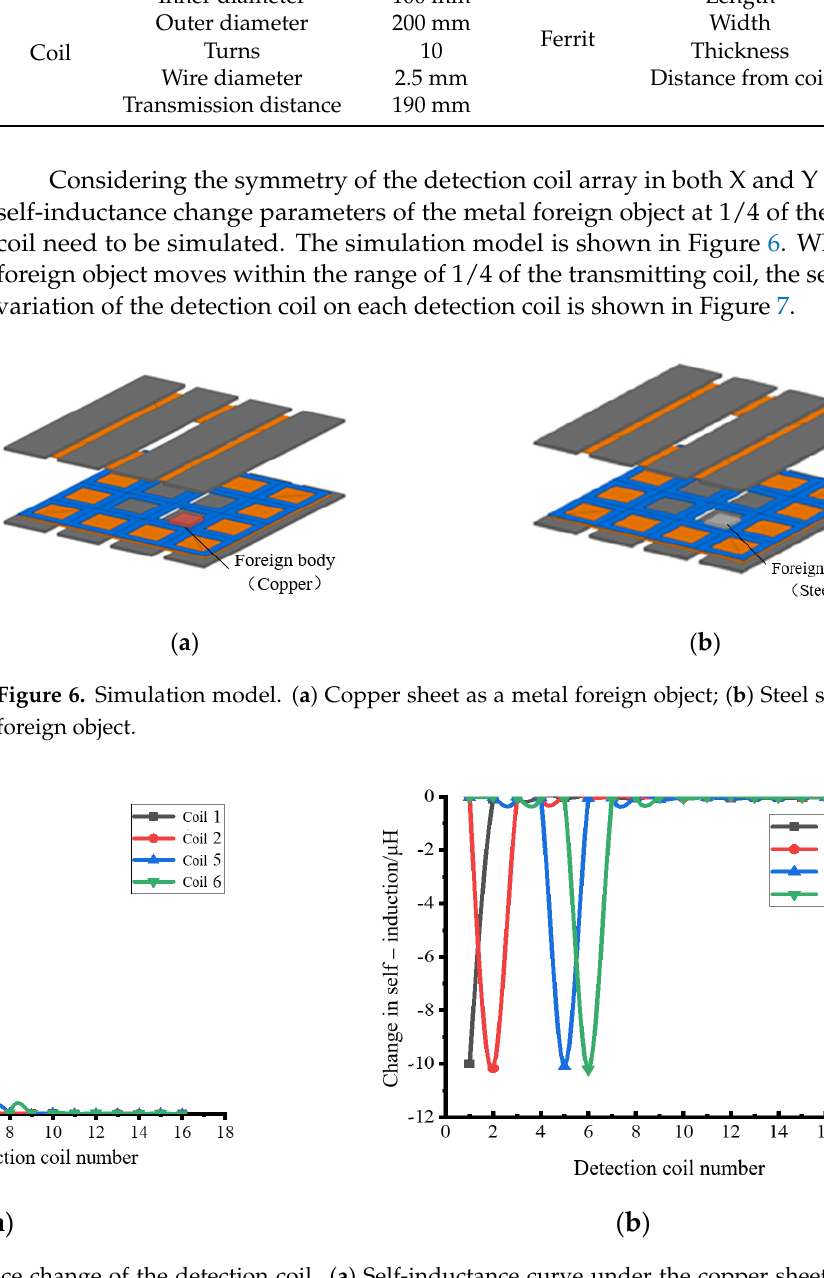
Table 4. System parameters. Figure 5. Symmetrically shaped detector coil array and WPT system coil.